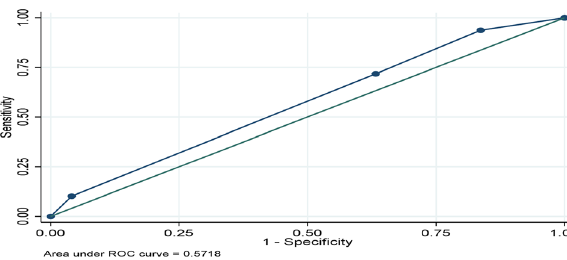
Fig. 8 ROC for GCE. Source: Researchers’